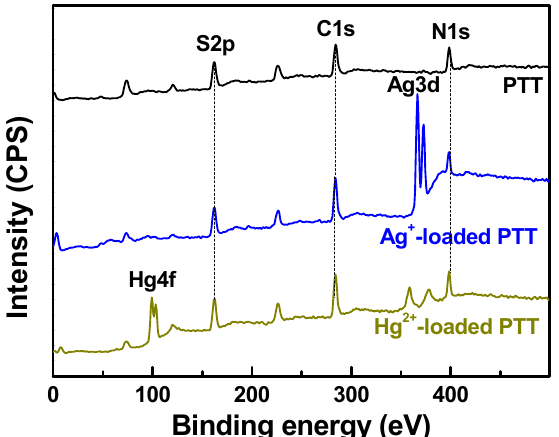
Figure 8. X-ray photoelectron (XPS) wide scan spectra of PTT, Ag + -loaded PTT and Hg 2+ -loaded PTT.